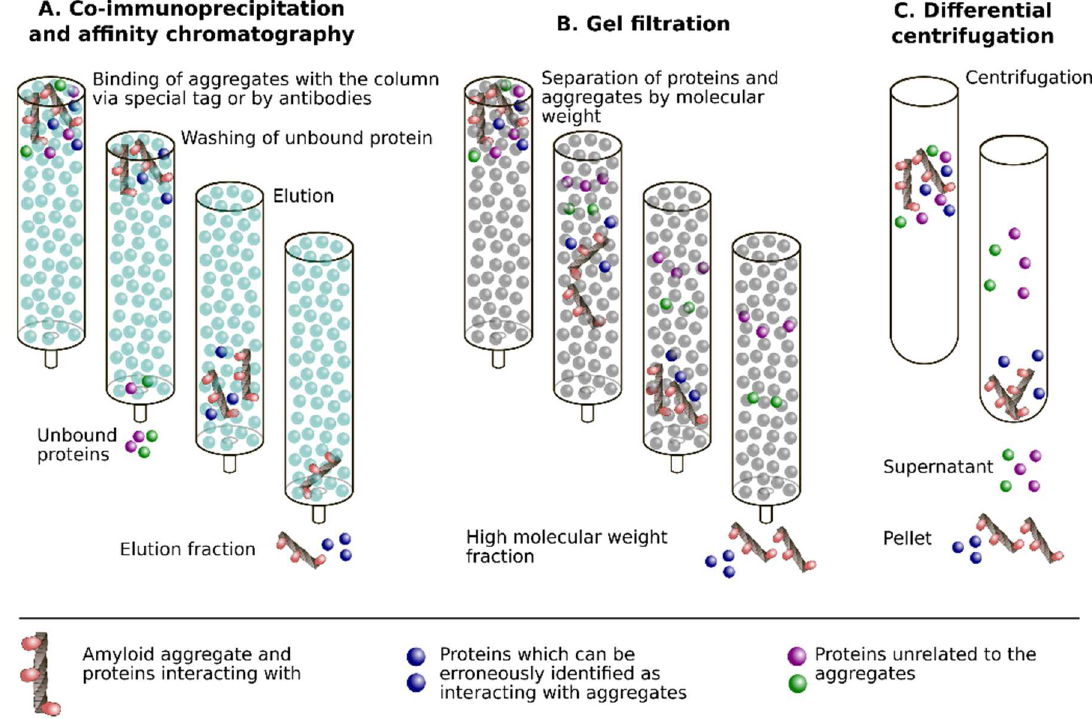
Figure 1. Schematic representation of approaches for identification of proteins co-aggregating with amyloids: co-immunoprecipitation or affinity chromatography ( A ), gel filtration ( B ) and differential centrifugation ( C ). In all approaches, some proteins can be erroneously identified as interacting with amyloids due to different reasons, listed below. In the case of co-immunoprecipitation (co-IP) or affinity chromatography, it is non-specific interaction with antibodies or with the affinity chromatography resin. The high molecular weight of the protein or its inclusion in various complexes may lead to the misleading assumption that the protein interacts with amyloids. Finally, independently on technique, the excess of the protein in the sample may cause erroneous results.